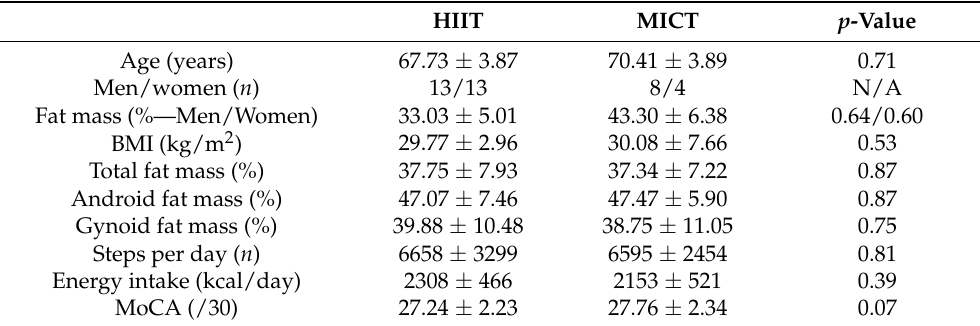
Table 1. Characteristics of participants at